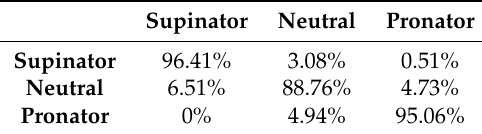
Table 6. Confusion matrix for the real-time